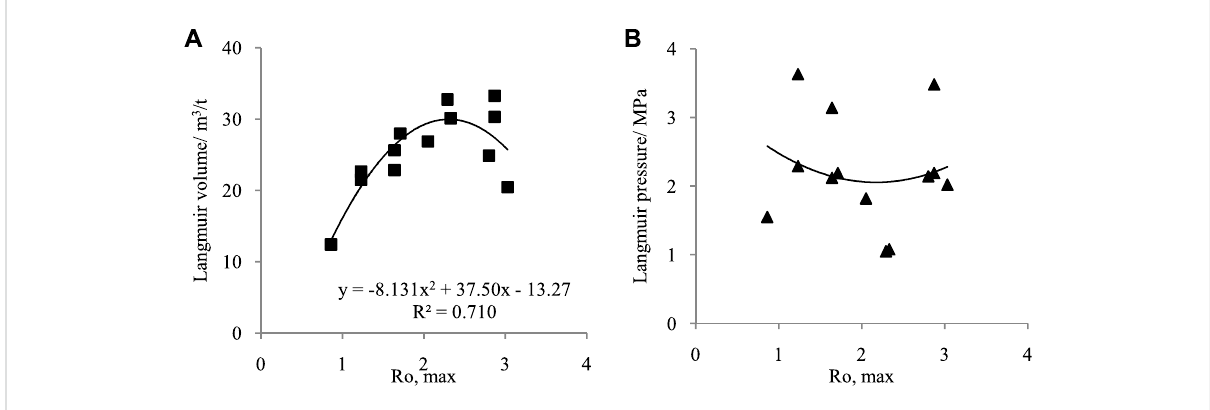
FIGURE 9 Fitting diagram between maximum vitrinite re fl ectance versus Langmuir volume (A) and Langmuir pressure (B) .